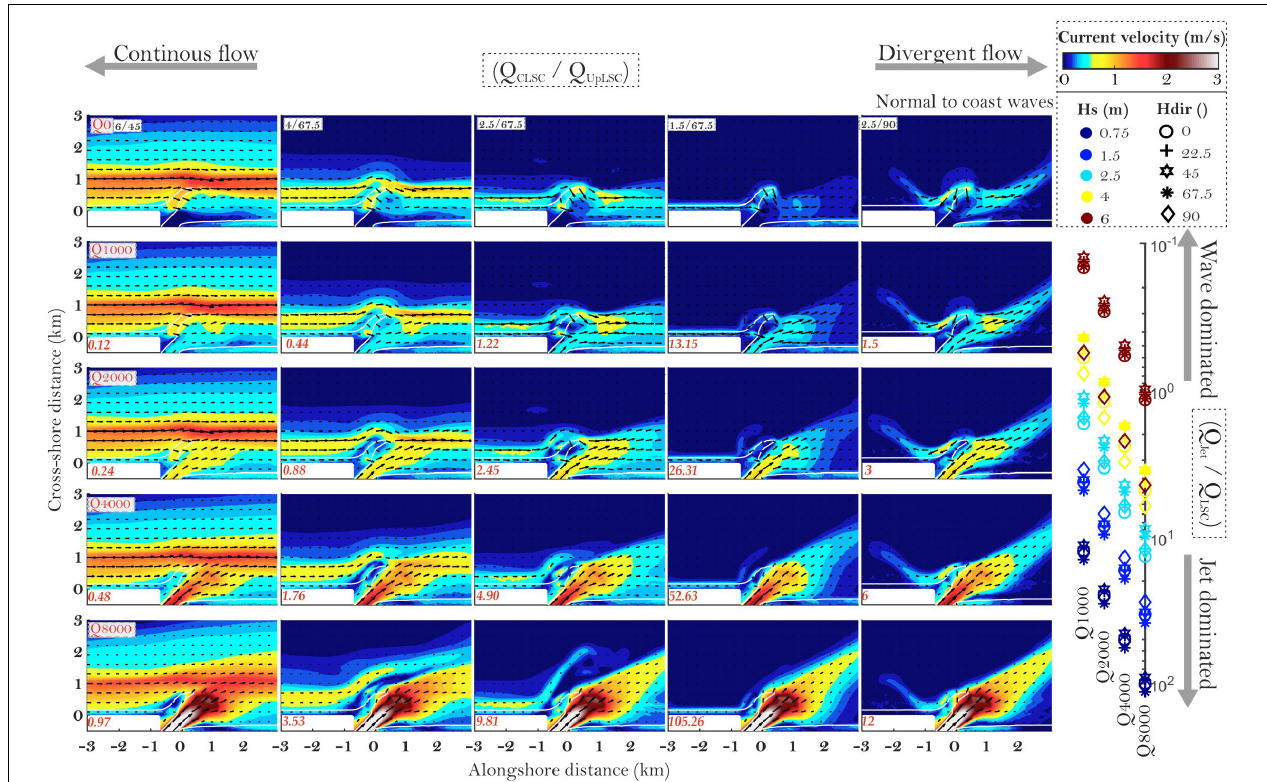
FIGURE 9 | Circulation patterns for the Assym RMB case with a selection of wave heights, directions, and river discharges. Values in left bottom corner of each plot show the Q Jet / Q LSC